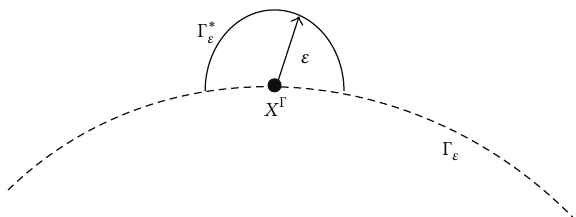
Figure 1: Source point on the boundary rounded by a semicircle.